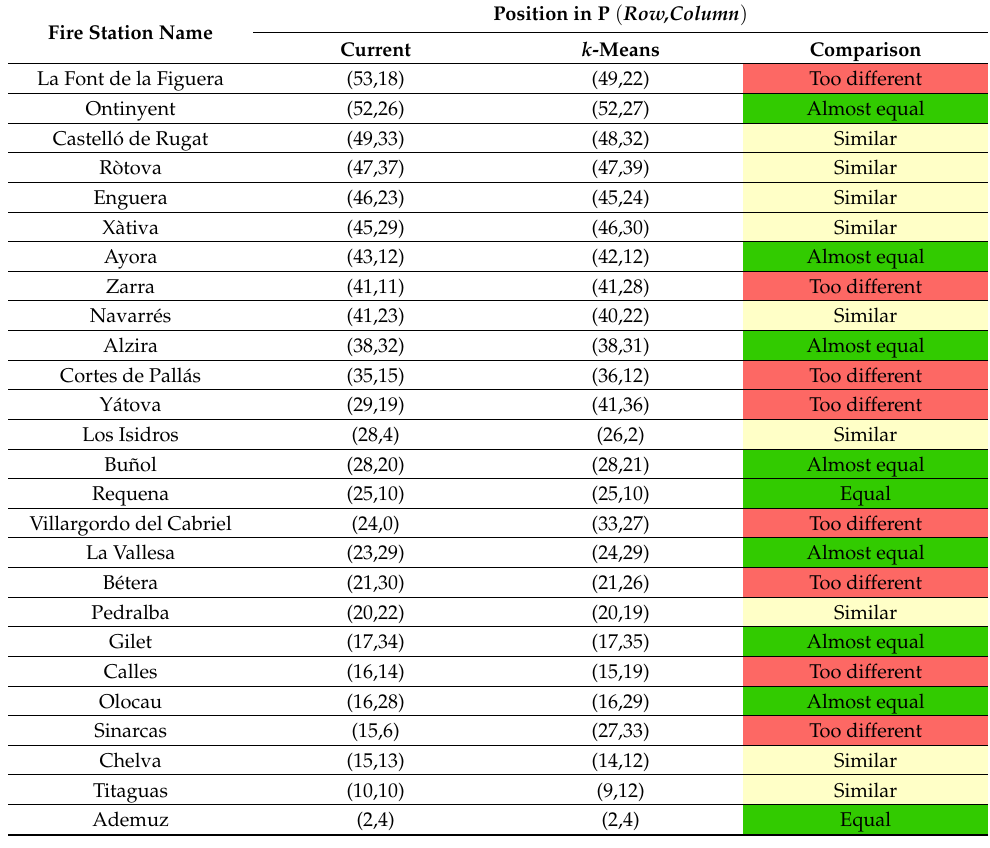
Table 2. Comparison of current fire station coordinates in the province with the centroid positions obtained through k